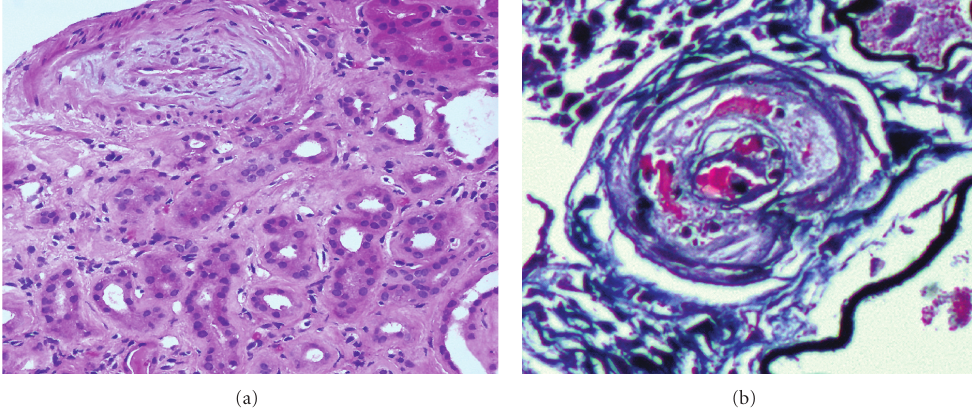
Figure 7: Two renal allograft biopsies with histologic features suspicious for recurrence of scleroderma. Note the prominent myxoid changes in the artery in biopsy (a) as well as the severe intimal thickening of blood vessels, which is accompanied by thrombosis and schistocytes within the arteriole wall in biopsy (b). The di ff erential diagnosis includes acute antibody-mediated rejection and acute calcineurin inhibitor toxicity. Clinical correlation with the presence of C4d stain, detection of circulating donor-specific antibodies, and calcineurin inhibitor levels are usually warranted to achieve a correct diagnosis [(a) H&E; original magnification x200 and (b) Methenamine silver stain; original magnification